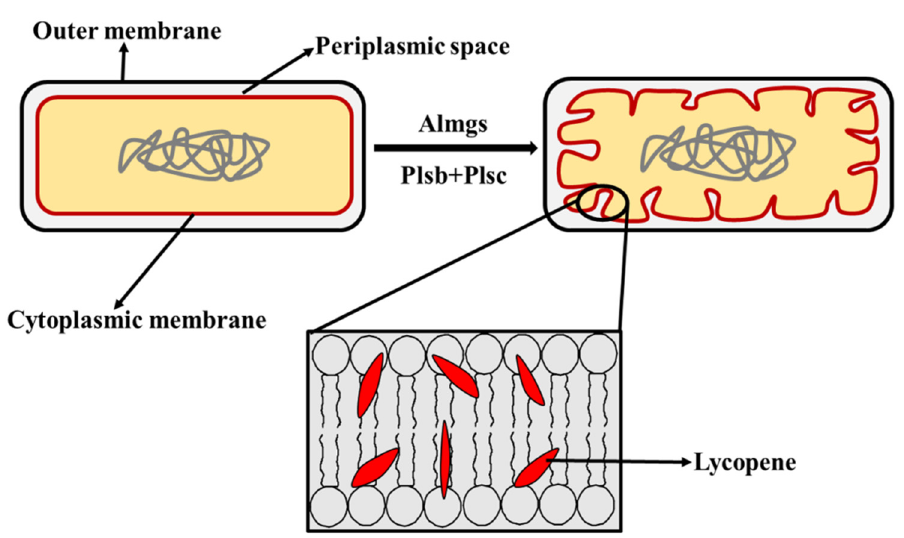
Figure 3. Diagram of membrane engineering strategy to increase the lycopene production in E. coli . Almgs, membrane-bending protein; Plsb, glycerol-3-phosphateacyltransferase; Plsc, 1-acylglycerol-3- phosphate-acyltransferase.